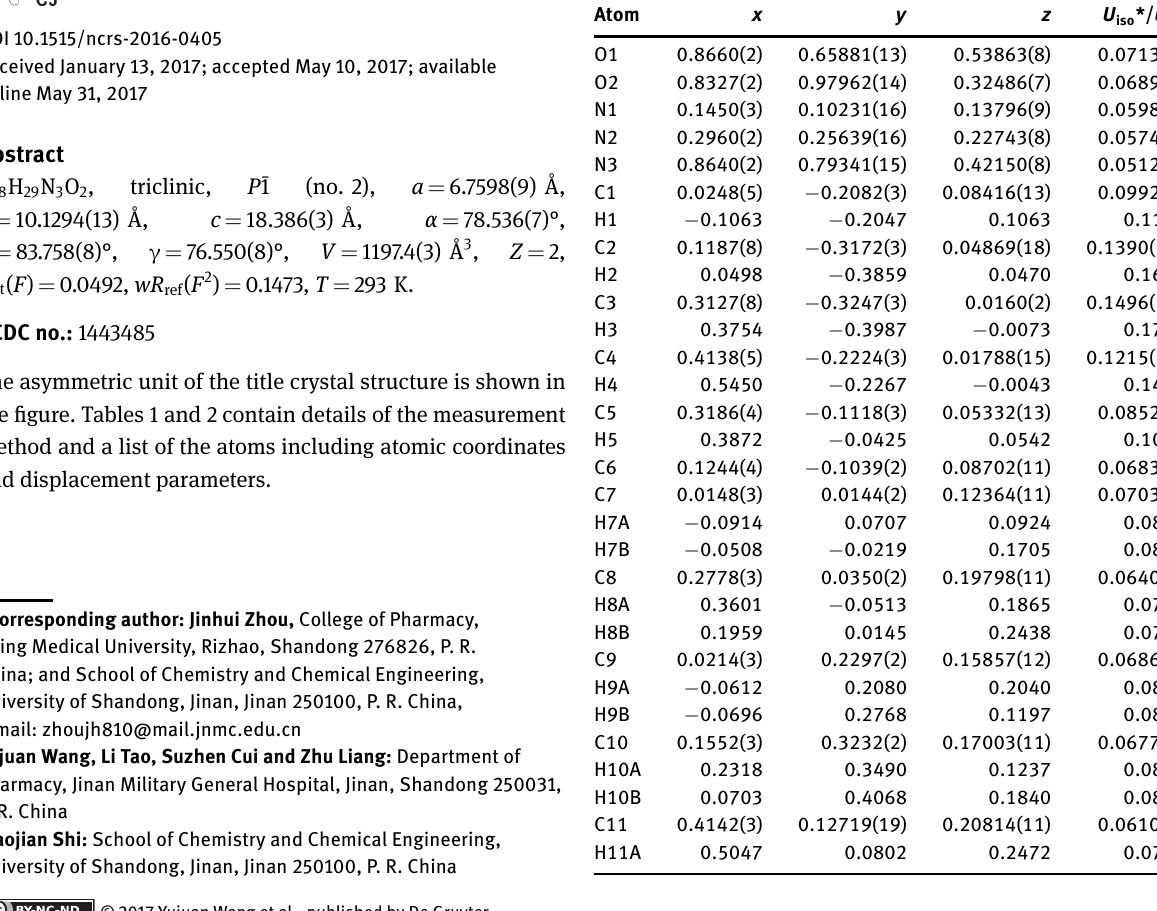
Table 2: Fractional atomic coordinates and isotropic or equivalent isotropic displacement parameters (Å 2